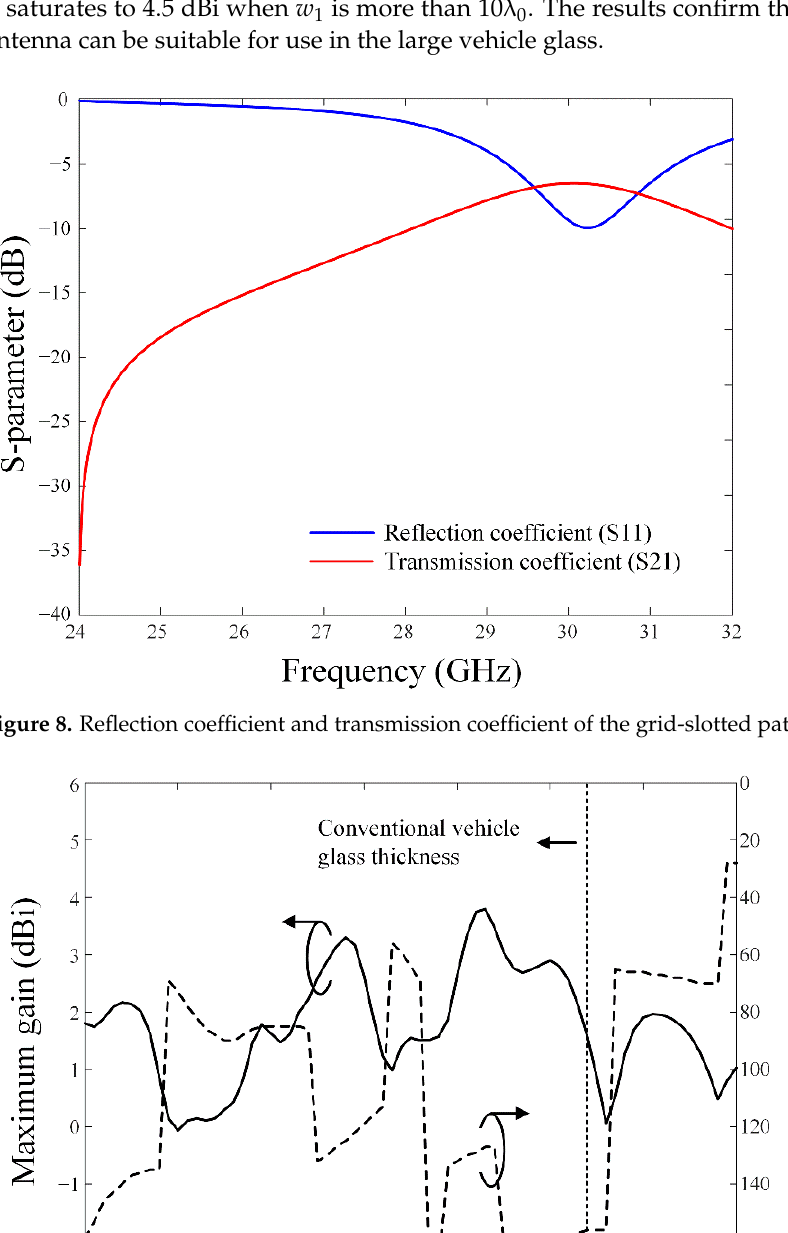
Figure 8. Reflection coefficient and transmission coefficient of the grid-slotted patch reflector.